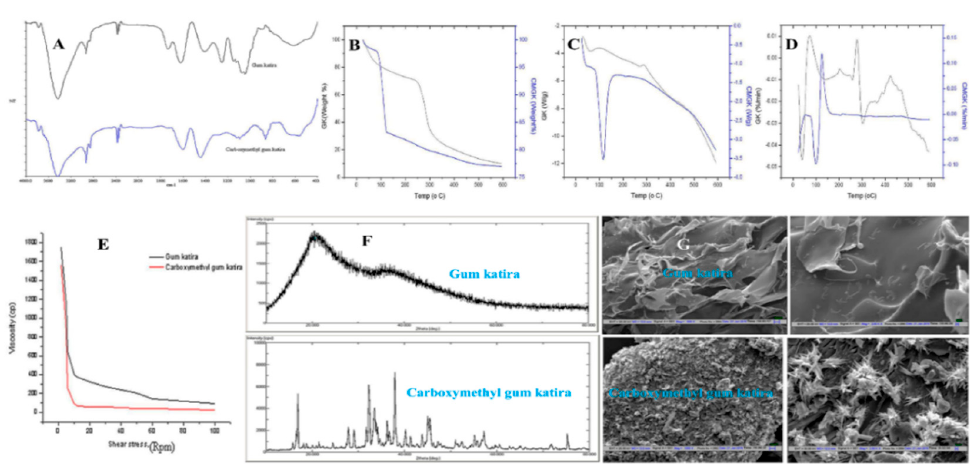
Figure 3. ( A ) FTIR, ( B ) TGA, ( C ) DSC, ( D ) DTG, ( E ) Viscosity, ( F ) XRD, and ( G ) SEM analysis of gum katira and carboxymethylated gum katira. Reprinted/adapted with permission from